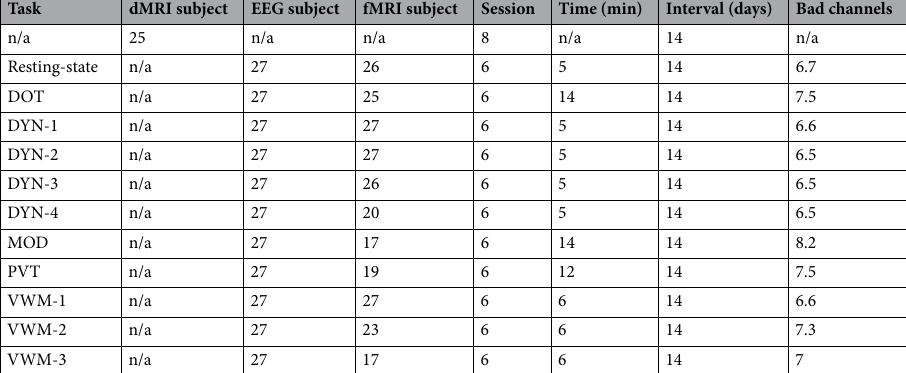
Table 1. Number of subjects, sessions, task length, and inter-session interval.